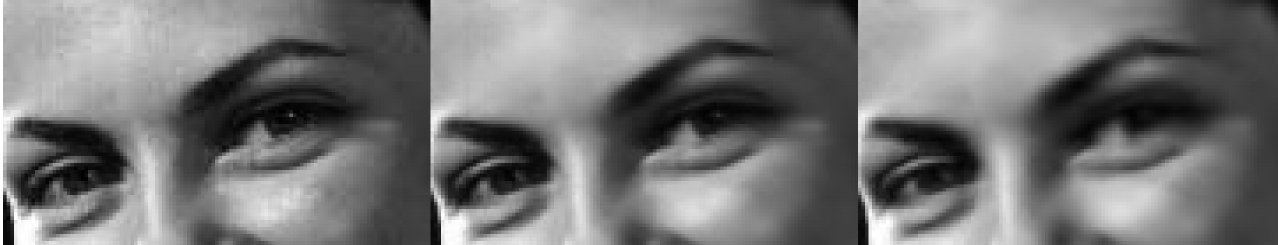
Figure 21. From left to right: detailed of images, recovered with Curvelet inverse transform after thresholding at 100%, 85%, and 75% of the accumulated magnitude of coefficients, obtained from Curvelet forward transform, which employs periodic DRT as founding tool for computing